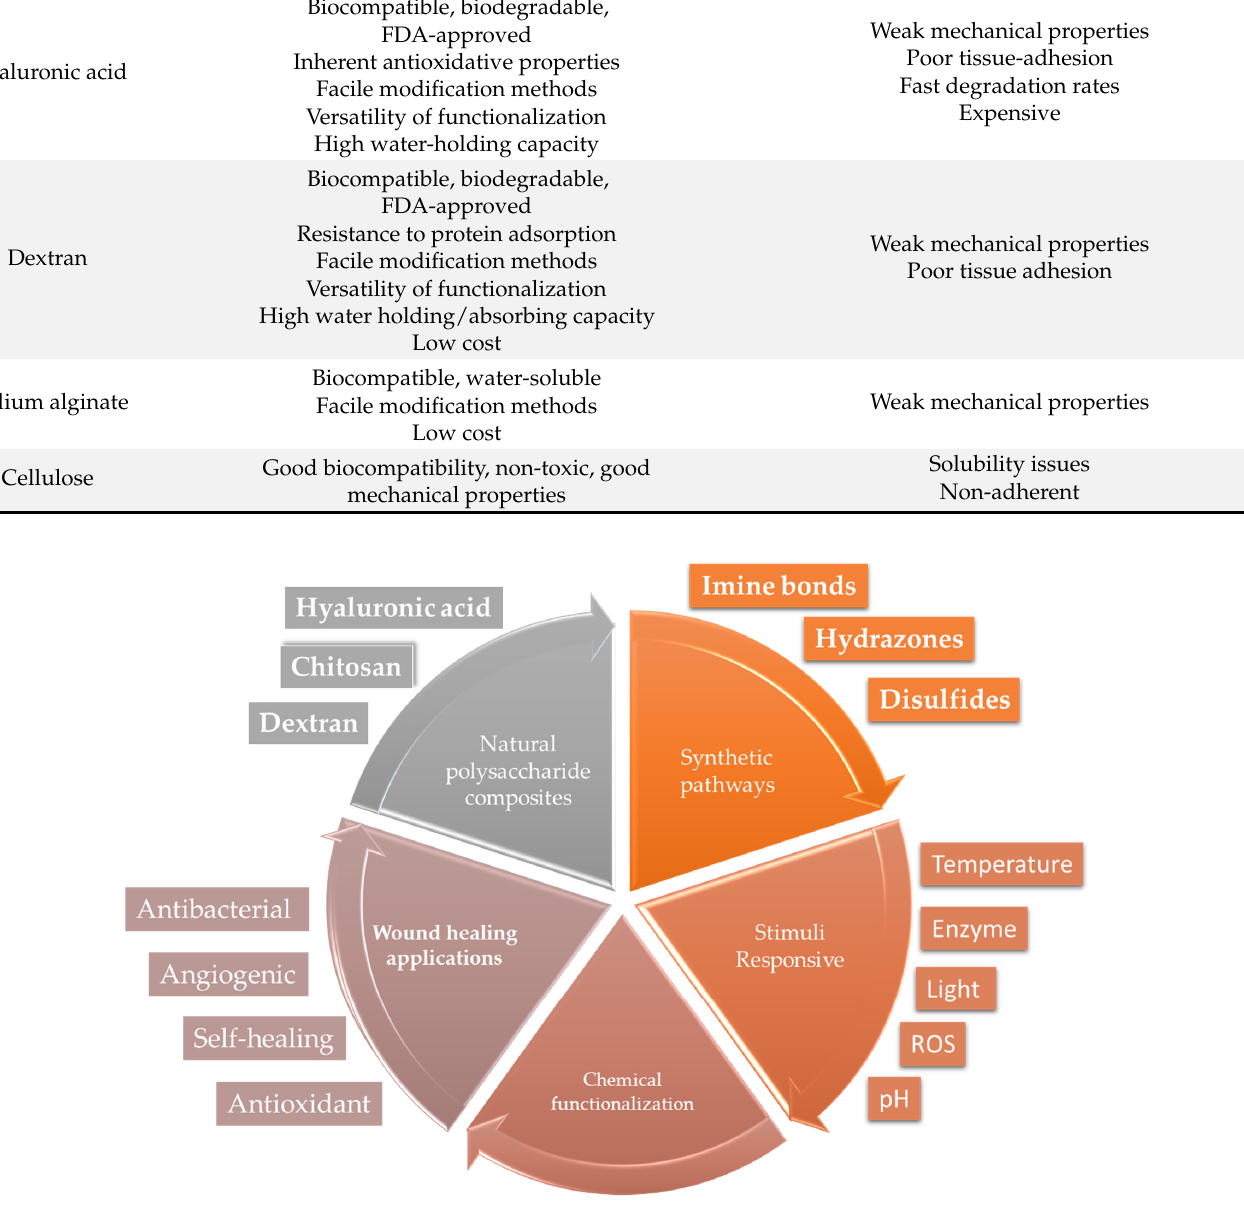
Scheme 1. Flow diagram of the main objectives presented in this Table 1. Major advantages and disadvantages of basic natural polysaccharides used in stimuli re- sponsive wound healing applications.